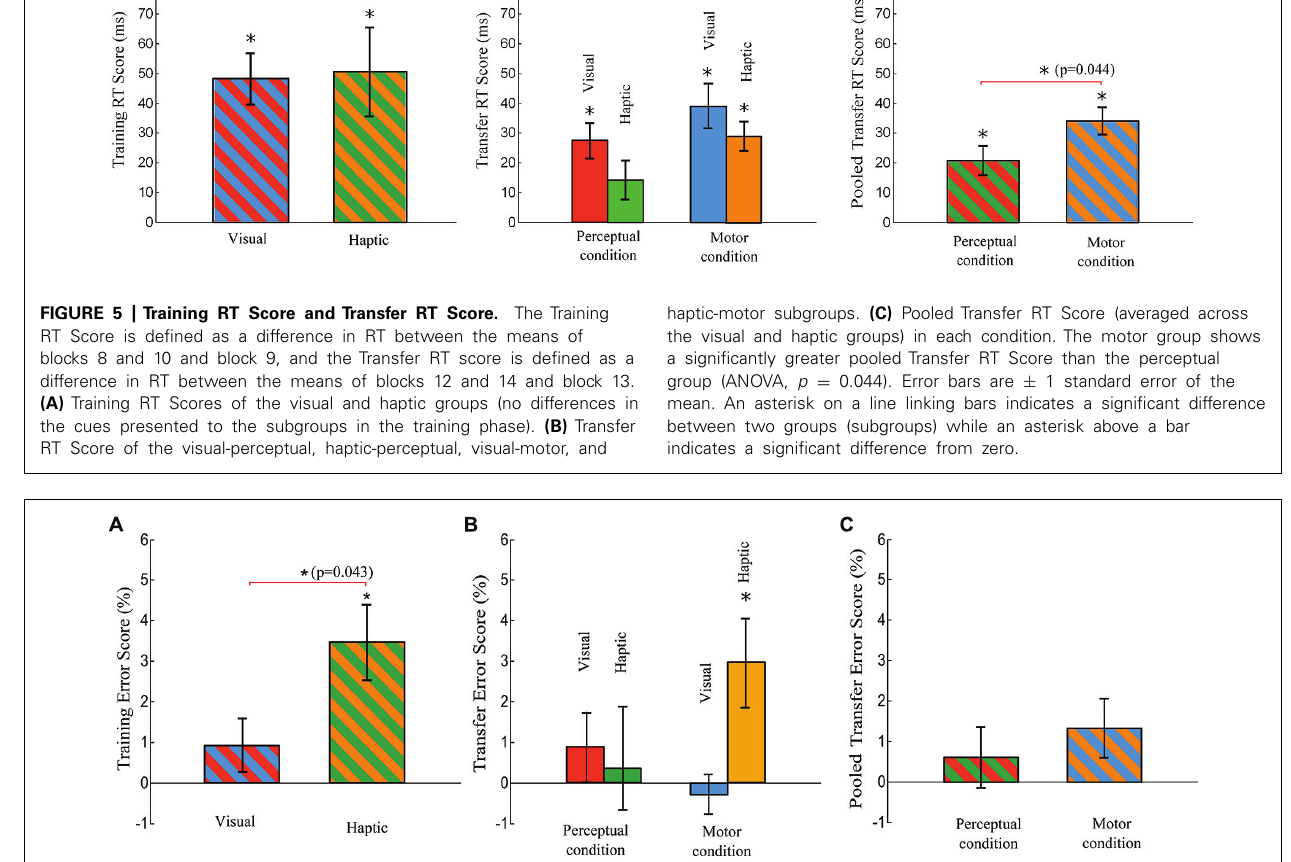
FIGURE 6 |Training Error Score andTransfer Error Score. TheTraining Error Score is defined as a difference in error rate between the means of blocks 8 and 10 and block 9, and theTransfer Error score is defined as a difference in error rate between the means of blocks 12 and 14 and block 13. (A) Training Error Scores of the visual and haptic groups.There is a significant difference between the two groups ( t -test, p = 0.043). (B) Transfer Error Score of the